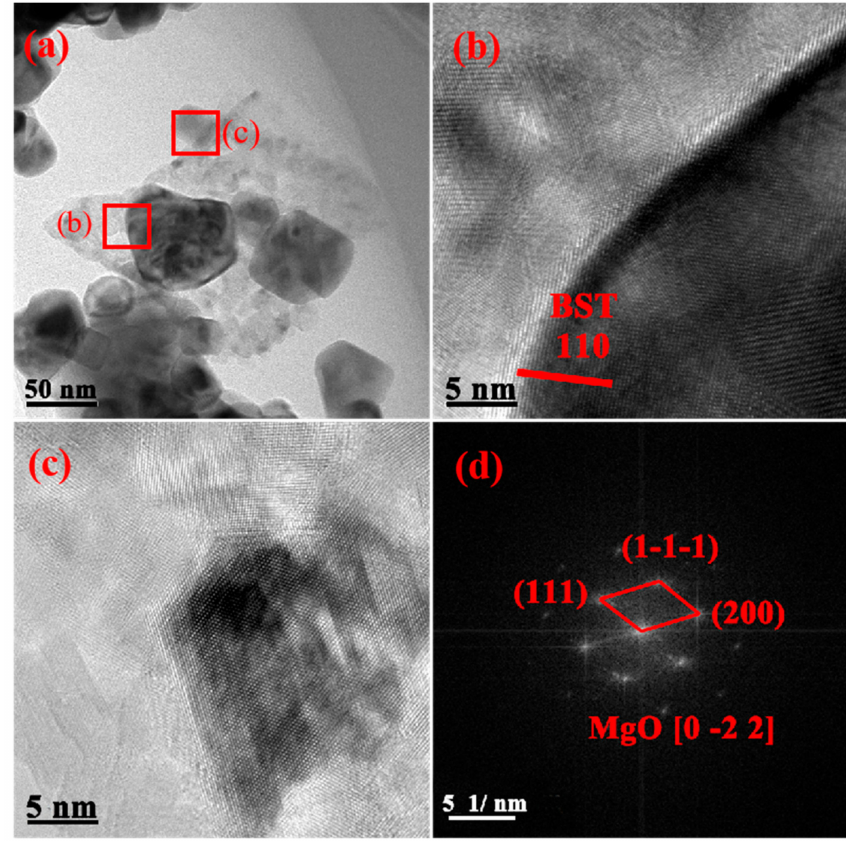
Figure 2. ( a ) TEM image of the BST-2 mol% MgO powder. ( b ) The high-resolution diagram of ( a ). ( c ) The high-resolution diagram of ( a ). ( d ) The Fourier transform figure of ( c